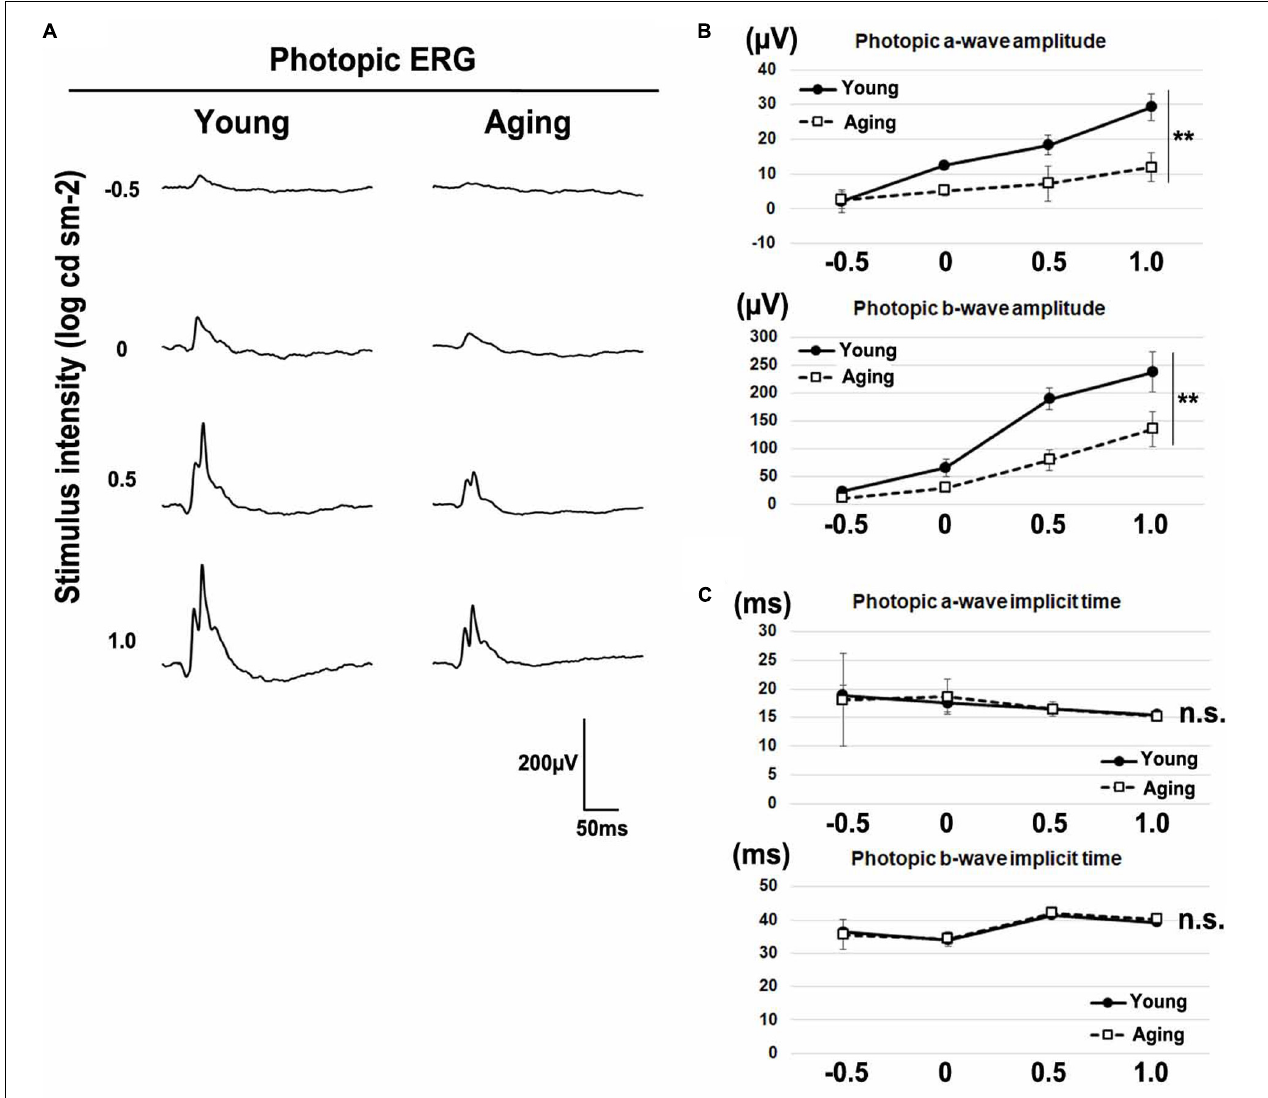
FIGURE 3 | Photopic ERGs in the aging mice. (A) Representative light-adapted (photopic) ERGs in the young adult and aging mice induced by four different stimulus intensities (–0.5, 0, 0.5, and 1.0 log cd s/m 2 ). (B) The amplitudes of photopic a- and b-waves are presented as a function of the stimulus intensity. (C) The implicit times of photopic a- and b-waves are presented as a function of the stimulus intensity. Error bars, mean ± SD ( n = 3 mice). Two-way repeated measures ANOVA (** p < 0.01, n.s., not